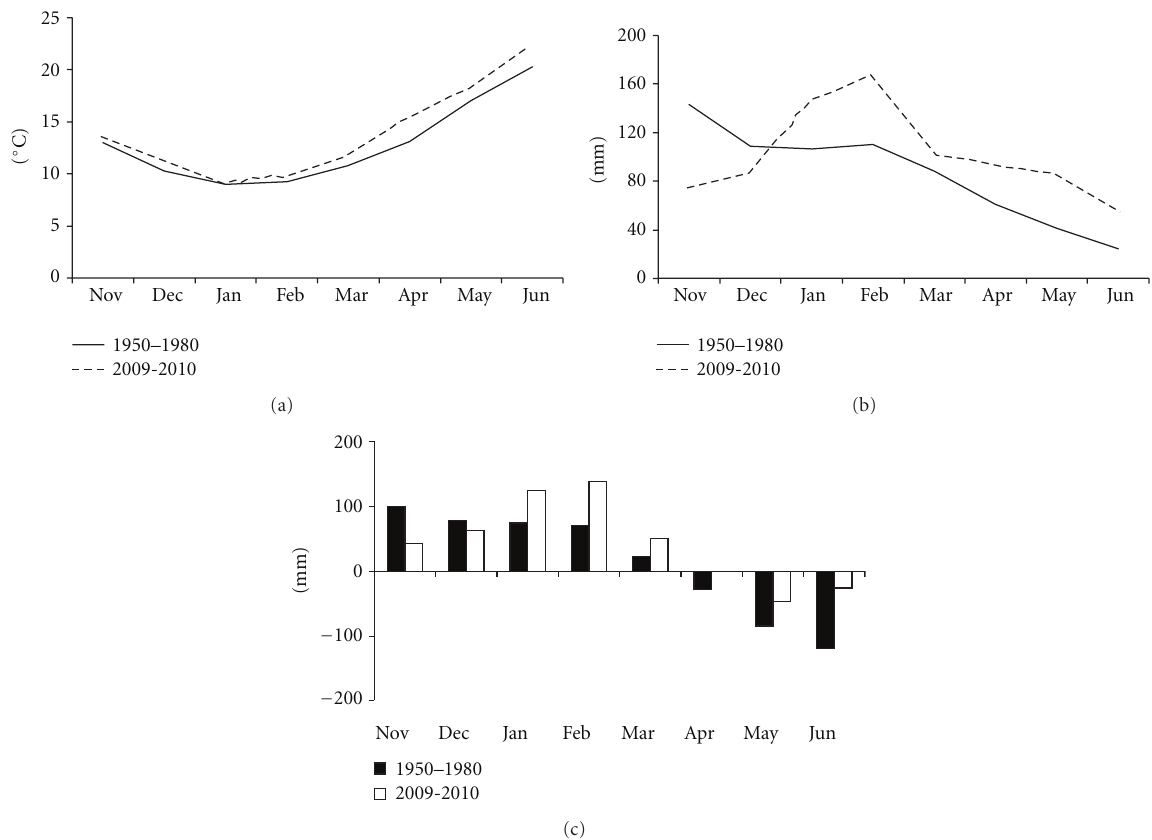
Figure 1: Average temperature (a), rainfalls (b), and water balance (c) during the growth period of wheat: 2009-2010 versus 1950–1980.